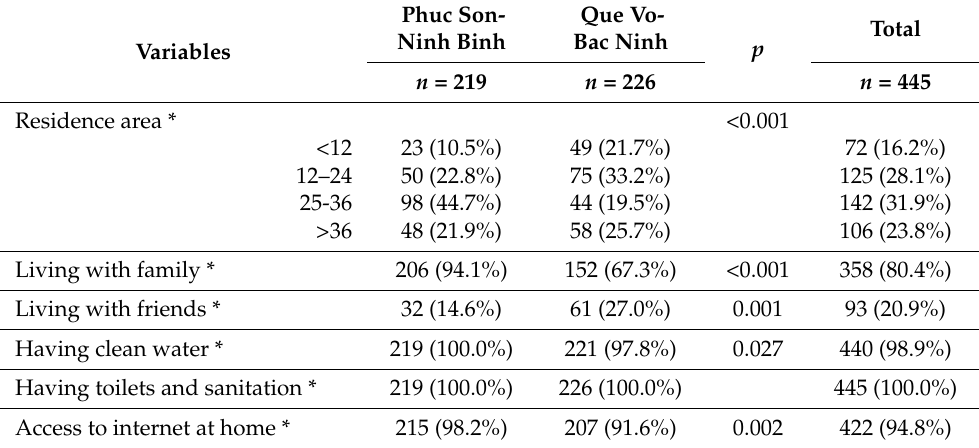
Table 4. Housing and living conditions of migrant